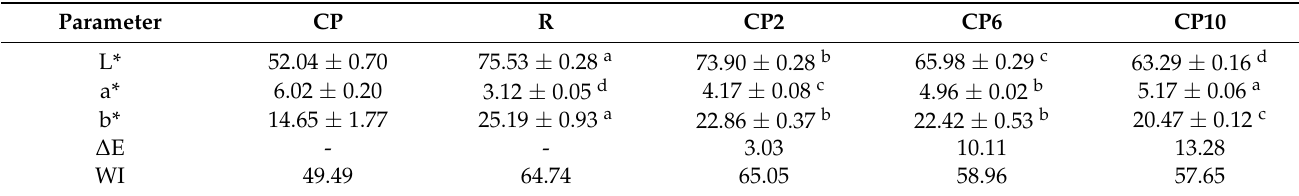
Table 1. Color parameters of cricket powder and biscuits.